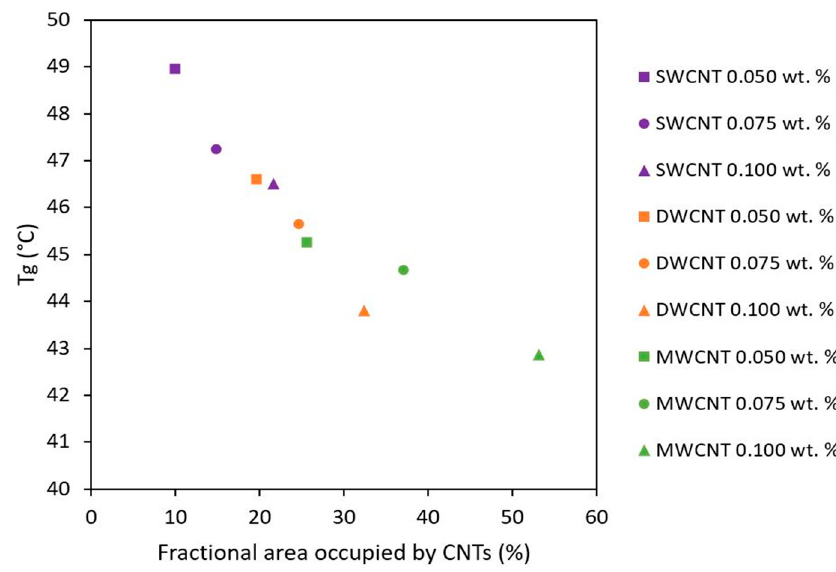
Figure 7. T g as a function of fractional area occupied by